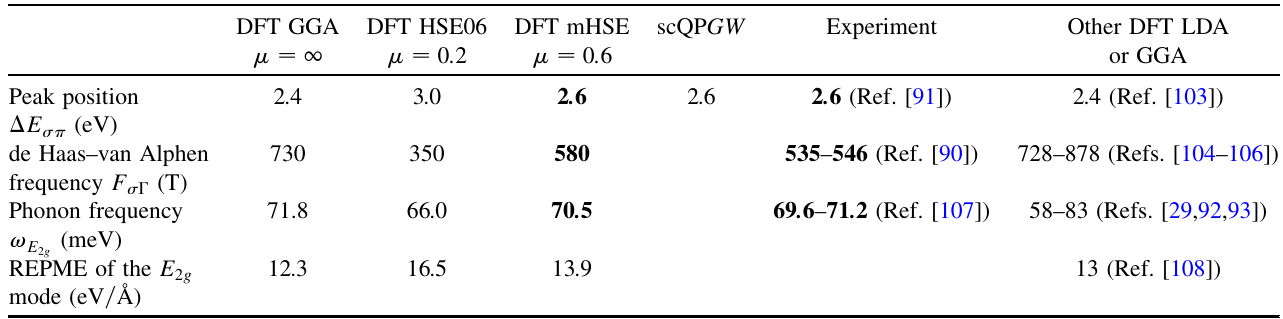
TABLE VII. Various quantities in MgB calculated by the DFT GGA, DFT HSE06, DFT mHSE ( (cid:3) ¼ 0 : 6 ), and scQP GW , and 2 compared to available experiments, including the first interband transition peak position (in eV) in optics, the de Haas–van Alphen mode, frequency (in T) from the Fermi surface formed by the lower (cid:10) band in the (cid:2) plane, the phonon frequency (in meV) of the E 2 g and the calculated reduced electron-phonon matrix electron (in eV = (cid:3)A ) of the E mode. 2 g DFT